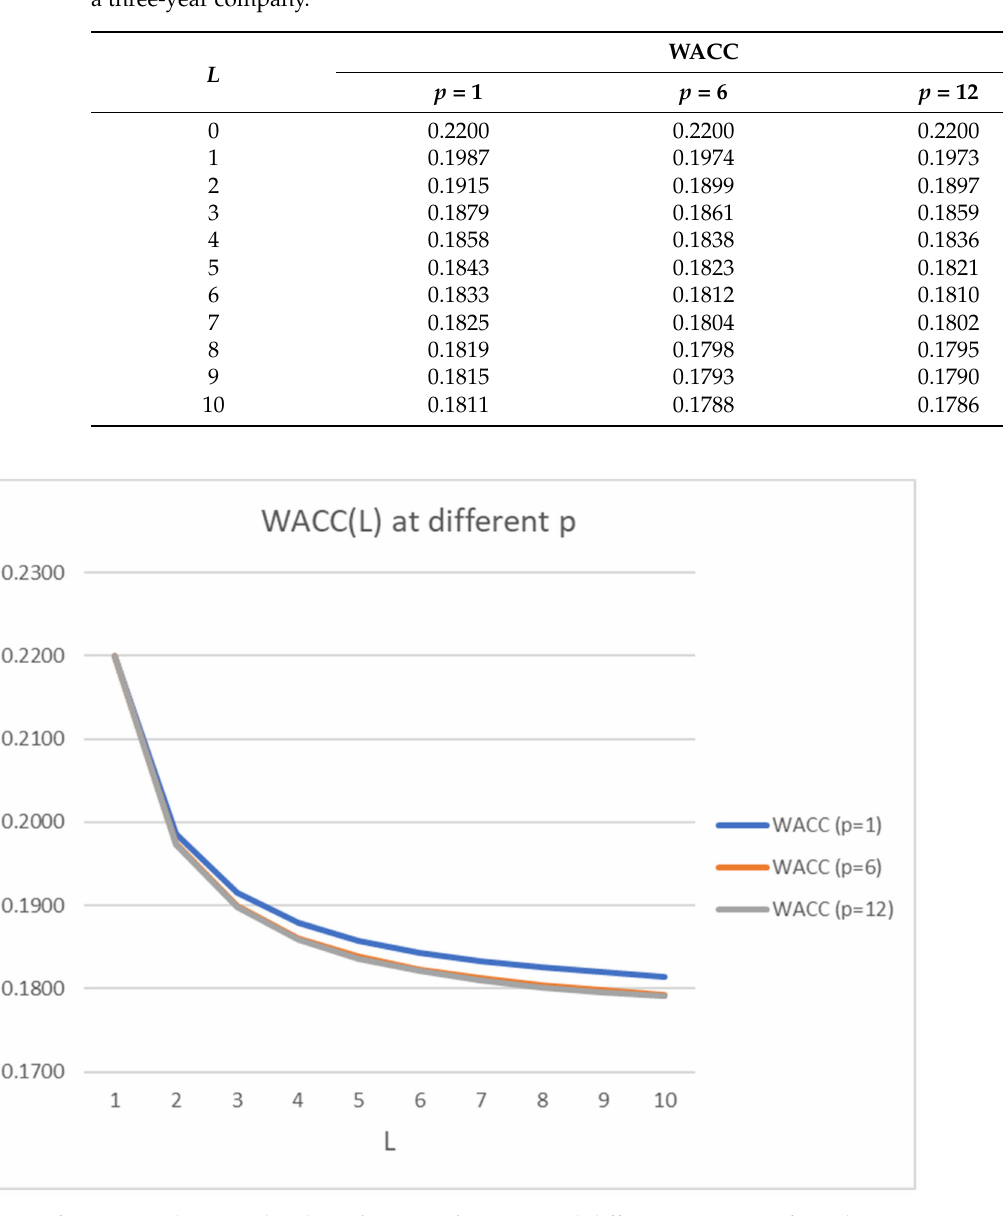
Figure 2. Dependence of WACC on leverage level L at k 0 = 0.22, k d = 0.14 and different p = 1, 6, 12 for a three-year